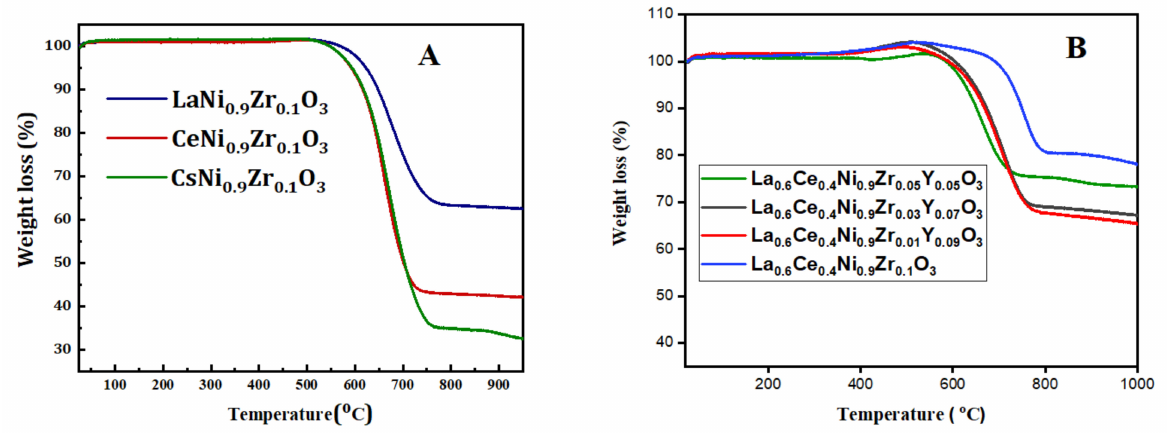
Figure 13. TGA curves of catalysts: ( A ) MNi 0.9 Zr 0.1 O 3 (M = La, Ce and Cs) at 1073 K; ( B ) La 0.6 Ce 0.4 Ni 0.9 Zr 0.1 − x Y x O 3 (x = 0.05, 0.07 and 0.09).